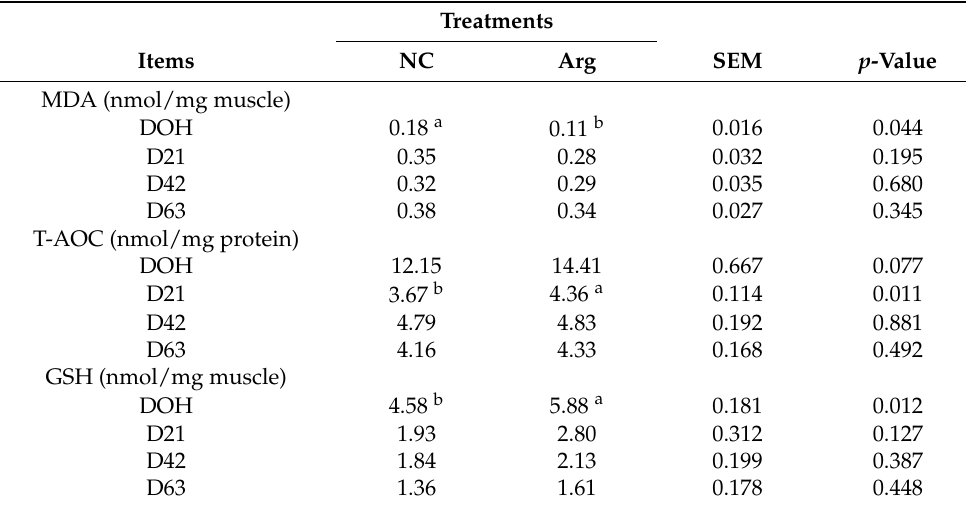
Table 5. Effects of in ovo feeding of L-arginine on antioxidant capacity in the breast muscle of slow-growing chickens.